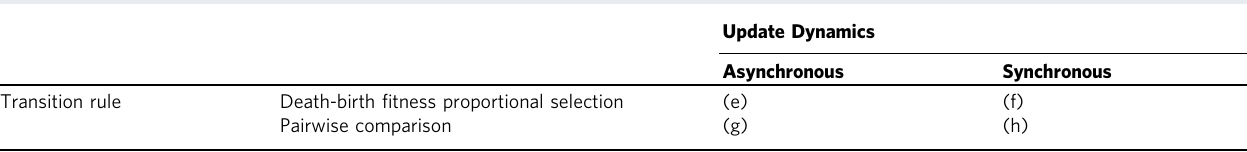
Table 2 Design of sensitivity analysis to study the effect of varying transition rules and update dynamics for the small-world network